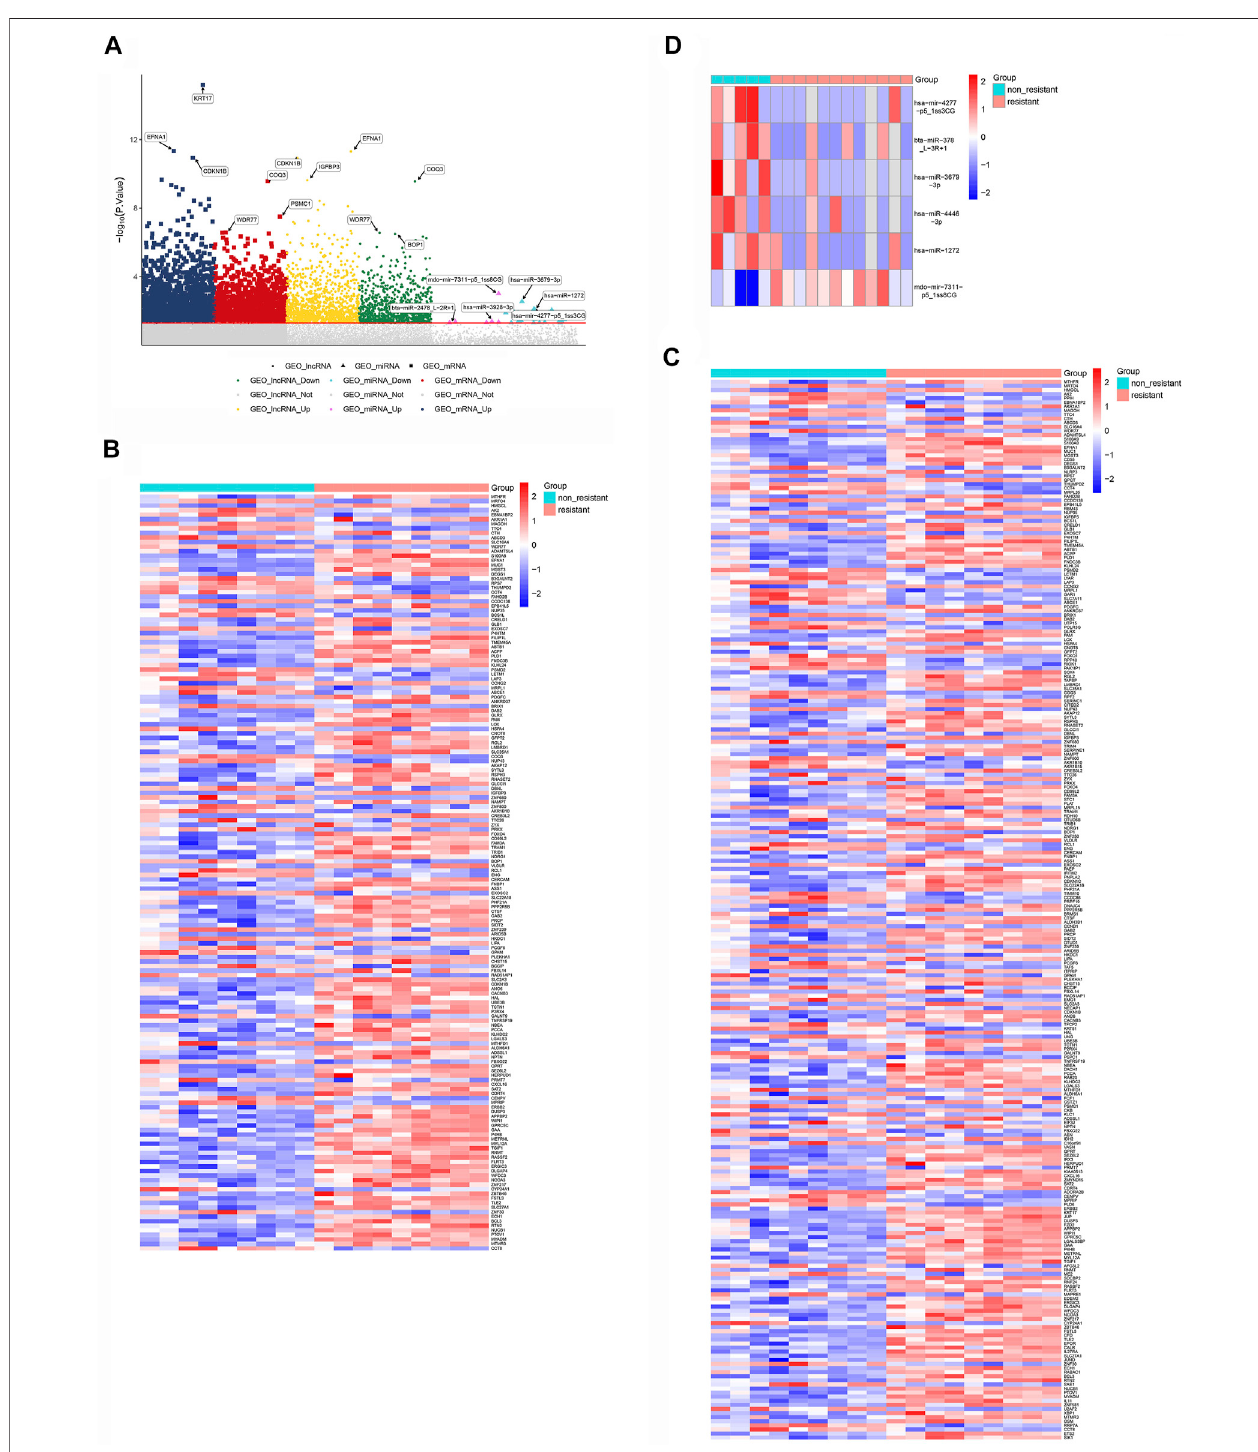
FIGURE 2 | Differentially expressed lncRNAs, miRNAs and mRNAs potentially associated with NSCLC resistance to EFRG-TKIs. (A) Manhattan chart, showing lncRNAs, mRNAs and miRNAs along the x -axis, and log 10 ( p value) for each gene along the y -axis. The gray dots below the dividing line indicate non-differentially expressed genes,whiledots ofothercolorsaredifferentially expressed genes.Thesigni fi cantlydown- and up-regulated differentially expressed RNAsaredepicted with different colors. (B) Differentially expressed lncRNAs. (C) Differentially expressed mRNAs. (D) Differentially expressed miRNAs.